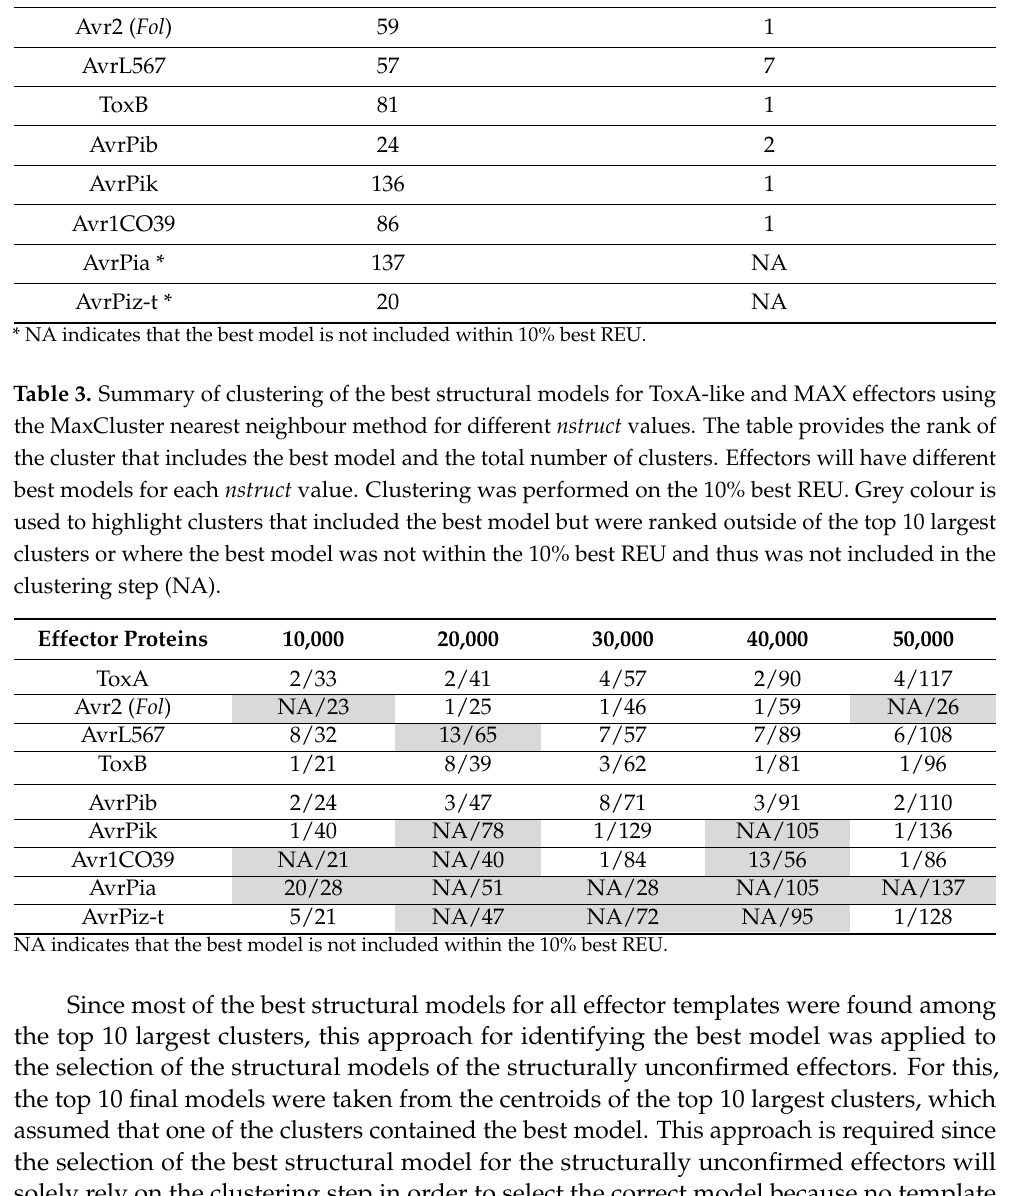
Table 2. Summary of clustering of the best structural models for ToxA-like and MAX effectors using the MaxCluster nearest neighbour method. The presence of the best structural model for each template was used as an indicator of successful clustering. The rank of the cluster that includes the best model and the total number of clusters for each effector are provided. Clustering was performed on the 10% best REU. Effector Protein Total Number of Clusters Cluster Rank with Best Structural Model ToxA 117 4 Avr2 ( Fol ) 59